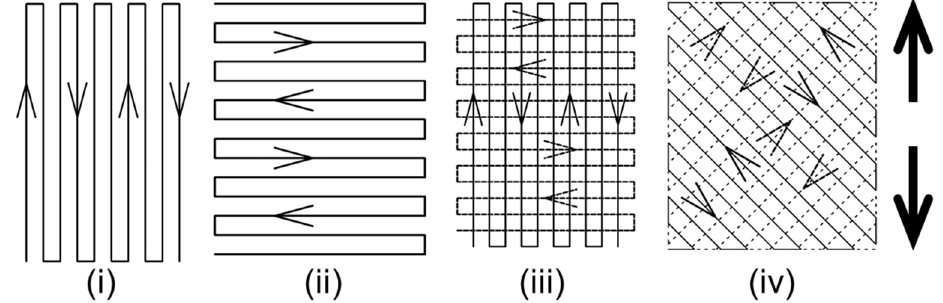
Figure 2. Scan patterns of the nozzle for test piece fabrication. ( i ) Parallel, P.; ( ii ) Vertical, V.; ( iii ) Parallel and Vertical, P.V.; ( iv ) Cross-hatched at opposing diagonal angles, C. The large arrow indicates the direction of the load in the tensile test.